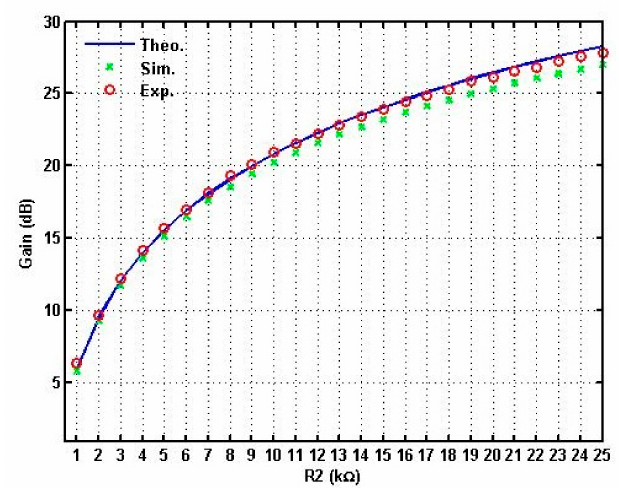
Figure 11. The theoretical, simulated and measured results of the independent amplitude adjustable NBPF voltage gains at the voltage output of V BP3 .